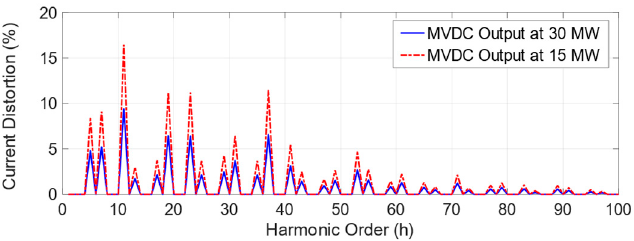
Figure 28. Output current spectra of an NPC converter for the two operating conditions.